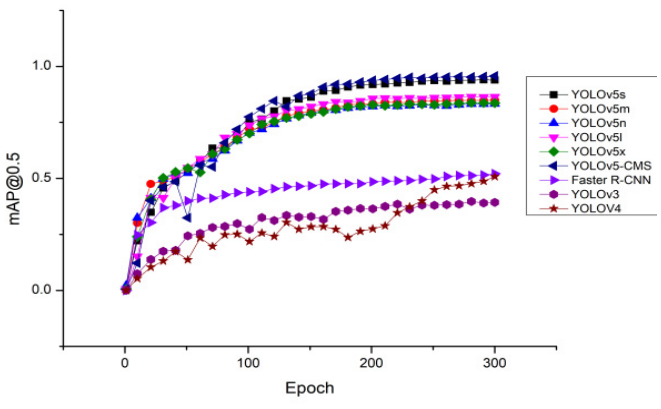
Figure 9. Comparison of mAP@0.5.